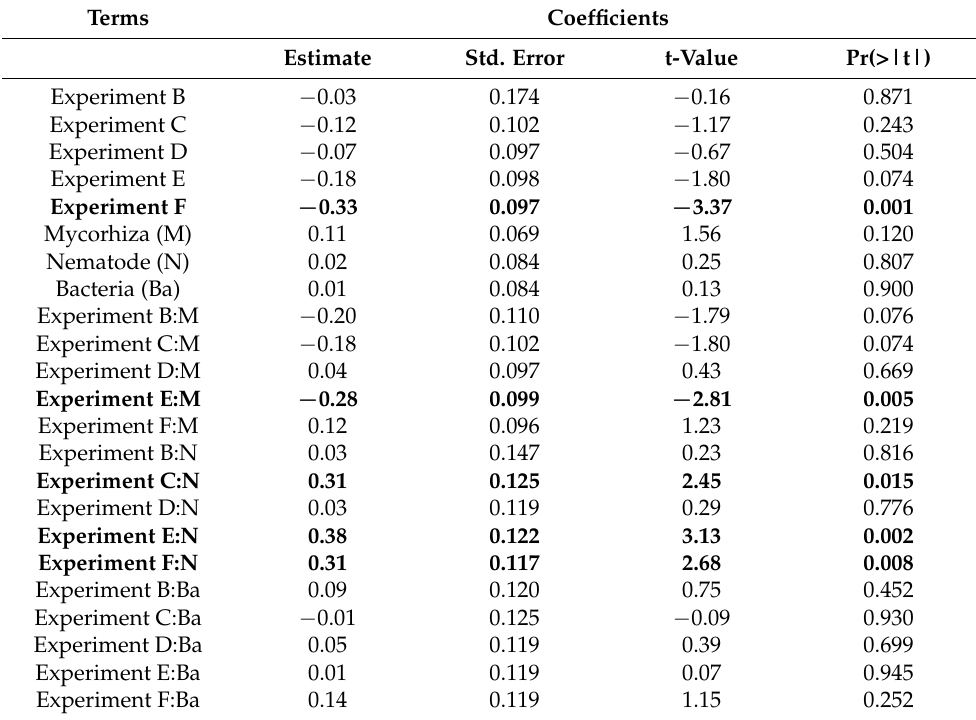
Table 2. Coefficients of the fitting generalized linear model (glm; AIC -61.653). Significant terms (<0.05 threshold) are in